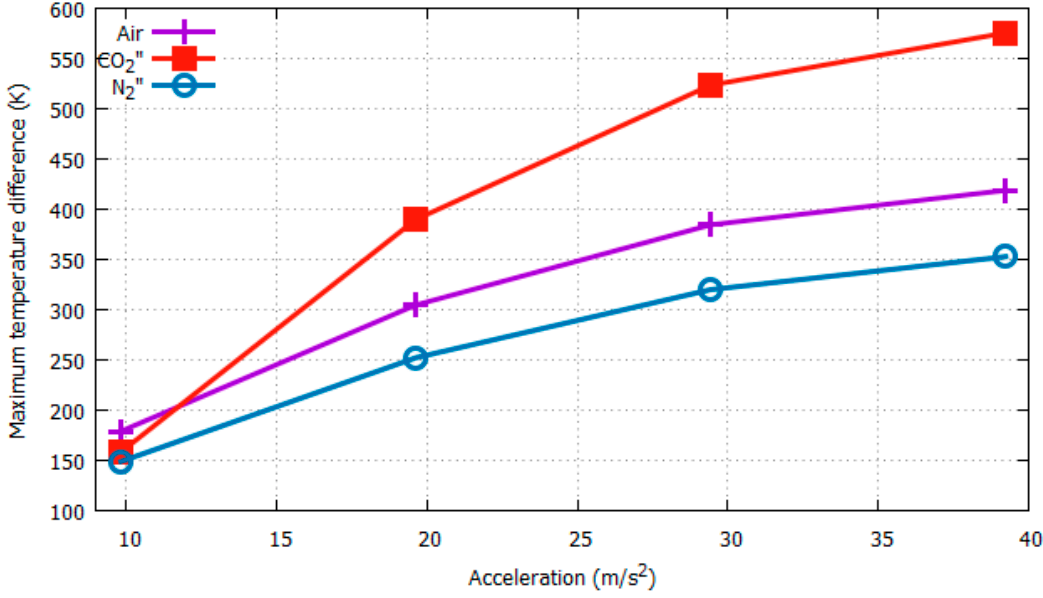
Figure 12. ∆ T_Y max w.r.t acceleration at 12.57 rad/s with varying gas media. Figure 12. Δ T_Y max w.r.t acceleration at 12.57 rad/s with varying gas media.